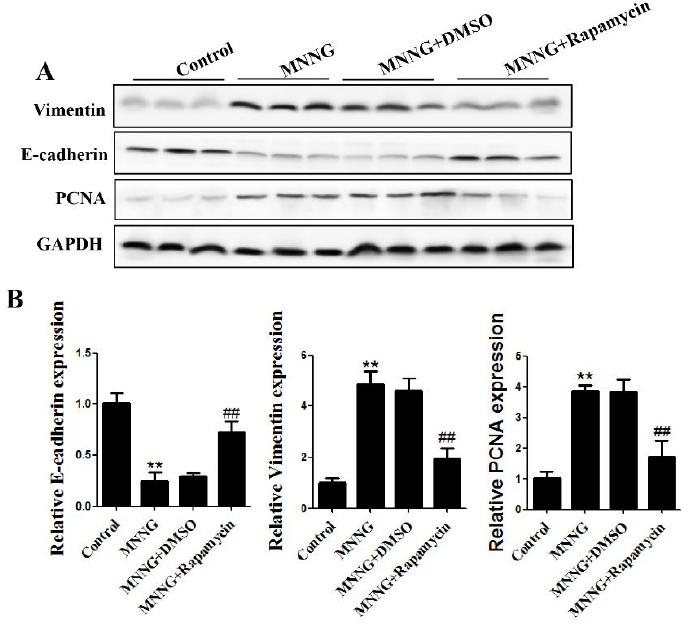
Figure 4. MMNG-mediated EMT and proliferation reversed by autophagy activation in the gastric tissues of rats. Rats were divided into a control group, an MNNG group, an MNNG and DMSO group, and an MNNG and rapamycin group: ( A ) Western blot analyzed the levels of EMT and proliferation markers. Tissues were from n = 3 rats as representative images; ( B ) real-time PCR analyzed the expression of EMT and proliferation markers. Real-time PCR results are from the samples from 3 rats and the experiment was repeated three times. GAPDH served as the housekeeping gene; ** P <0.01, compared with control group; # P < 0.05; ## P < 0.01; compared with MNNG group.